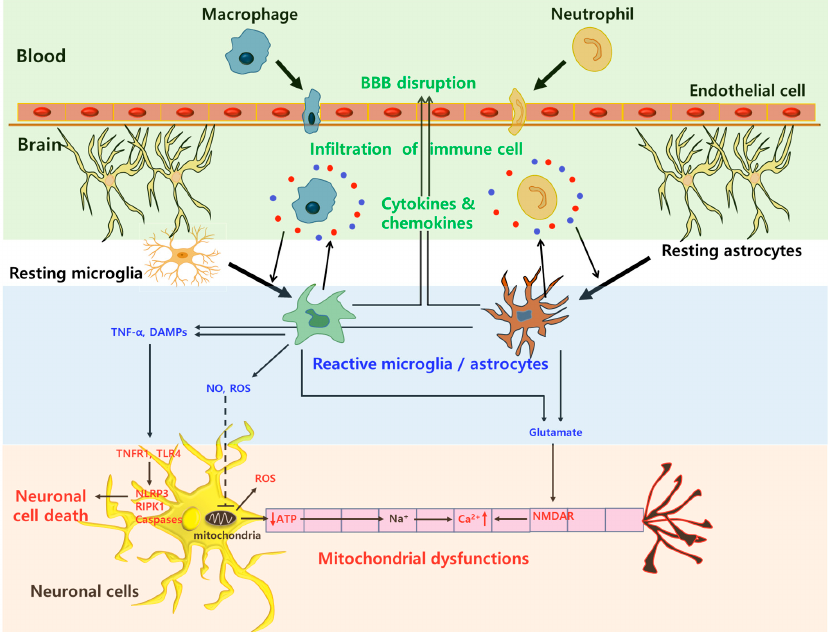
Figure 1. Schematic illustration of neuroinflammation processes by immune cell infiltration, reactive glial cells, and mitochondrial excitotoxicity. Blood–brain barrier (BBB); Tumor necrosis factor- α (TNF- α ); Damage-associated molecular patterns (DAMPs); Nitrogen oxide (NO); Reactive oxygen species (ROS); TNF receptor 1 (TNFR1); Toll-like receptor 4 (TLR4); Nucleotide-binding oligomerization domain (NOD)-like receptor (NLR) pyrin domain 3 (NLRP3); Receptor-interacting protein kinase-1 (RIPK1); Adenosine triphosphate (ATP); N-methyl-D-aspartate receptor